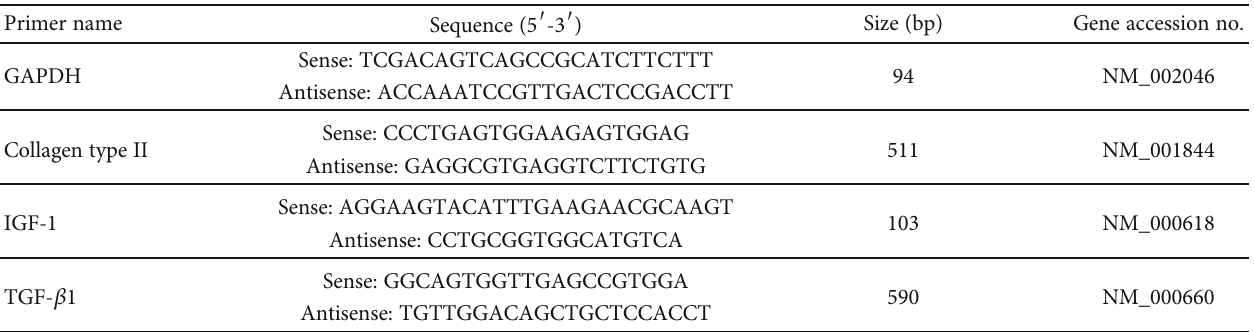
Figure 1: The experimental protocol and method. (a) Puri fi ed adipose-derived stromal cells (ADSCs; 2 × 10 7 cells/mL ) or 10 μ g/50 μ L of the secretome was injected subperichondrially (S.P.) into 2cm diameter, surgically created, auricular cartilage defects (b) on days 0, 2, 4, 6, and 8. The materials were injected (using a 26-gauge needle) at the edge of the excision site (c), and Spongostan was sutured to each defect (d). Table 1: Reverse transcription-polymerase chain reaction primer